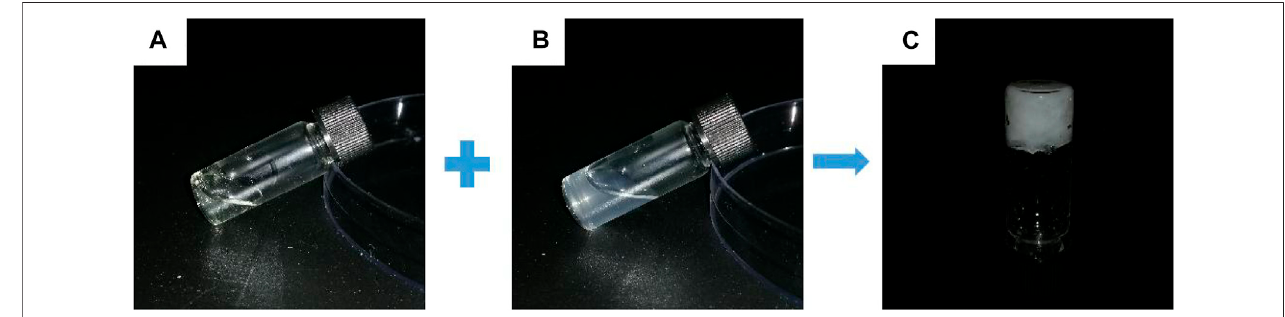
FIGURE 2 | Gel-forming picture of the hydrogel. (A) CMCS aqueous solution (B) Oxy PDA100 aqueous solution and (C) OCP100 hydrogel.